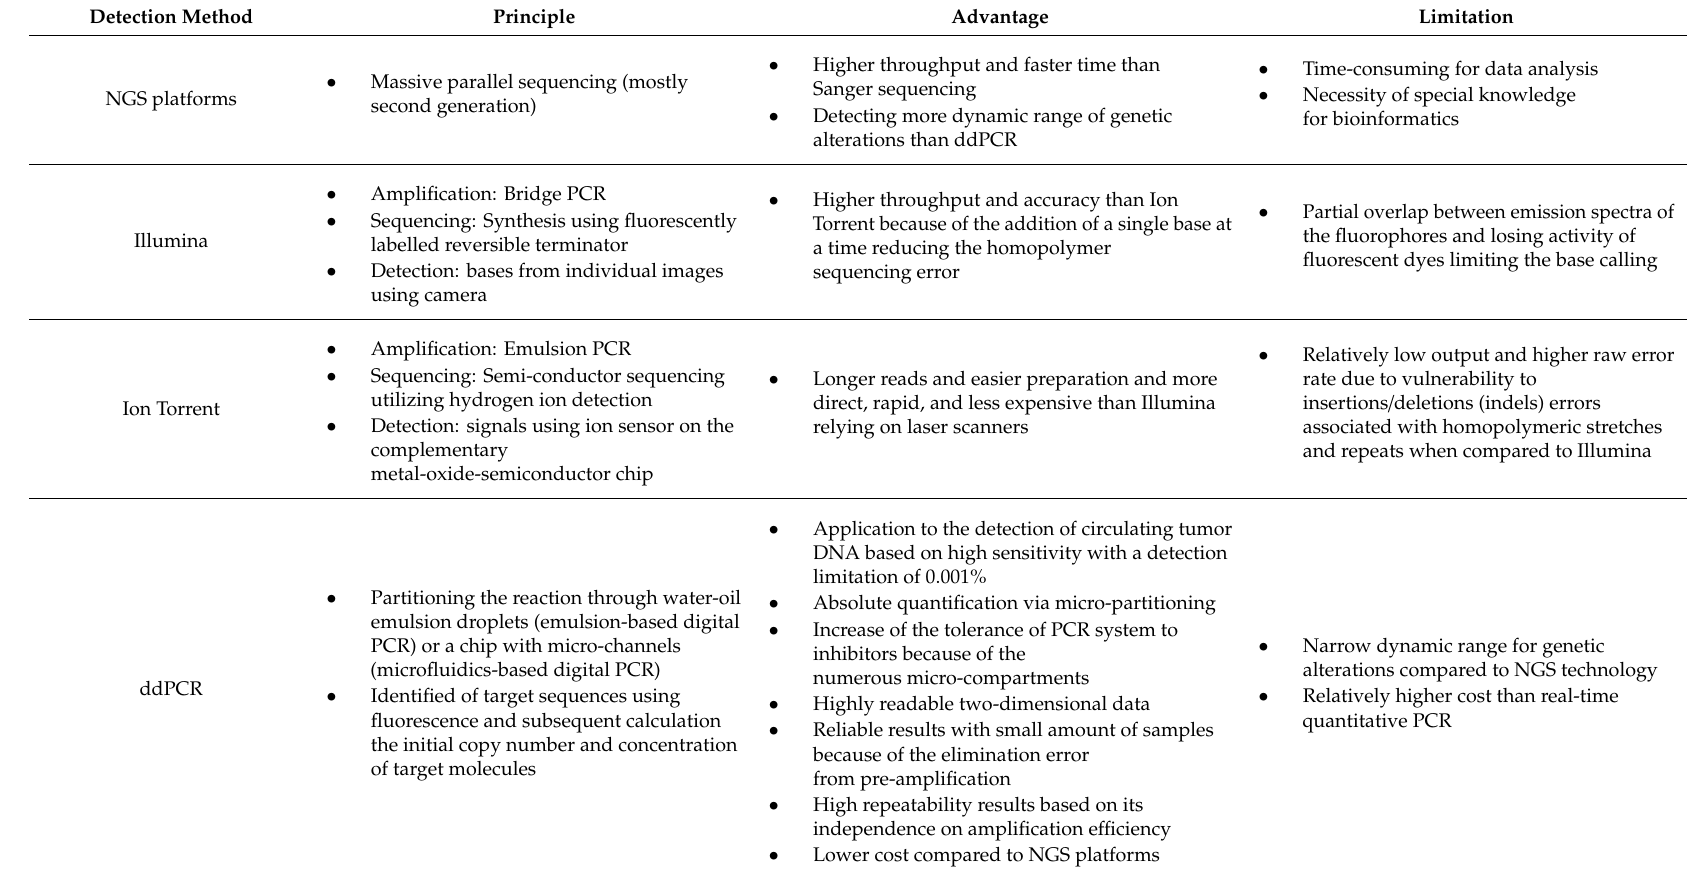
Table 2. Summary of commonly used molecular assays for the detection of ESR1